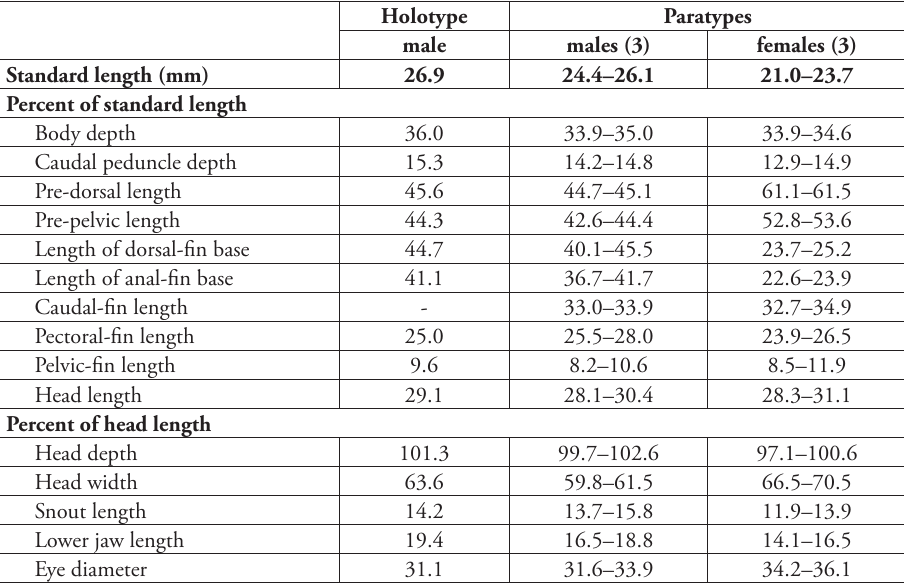
Table 3. Morphometric data of Hypsolebias hamadryades sp. n. Caudal fin of holotype damaged and regenerated, thus not